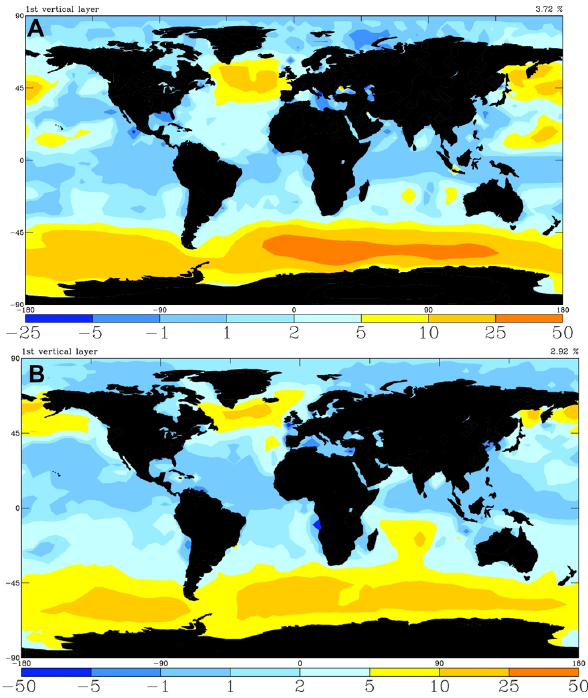
Fig. 4. Relative change (in percent) in CCN(0.2%) concentrations assuming that marine OC does not replace sea salt and is instead added on top of existing sea spray aerosol (S σ -ORG-ADD versus S σ -BASE-ADD). Panel (A) is a three-month seasonal average over December, January, and February, and panel (B) is averaged over June, July, and August. In both simulations, marine organics are treated as surfactants.